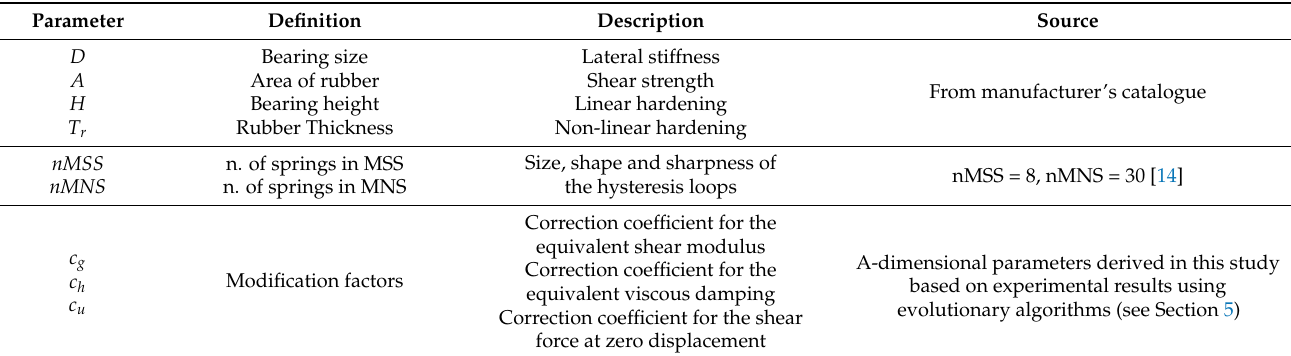
Figure 5. Model representation of the Kikuchi bearing element. Table 3. Geometric Parameters of the Kikuchi Bearing